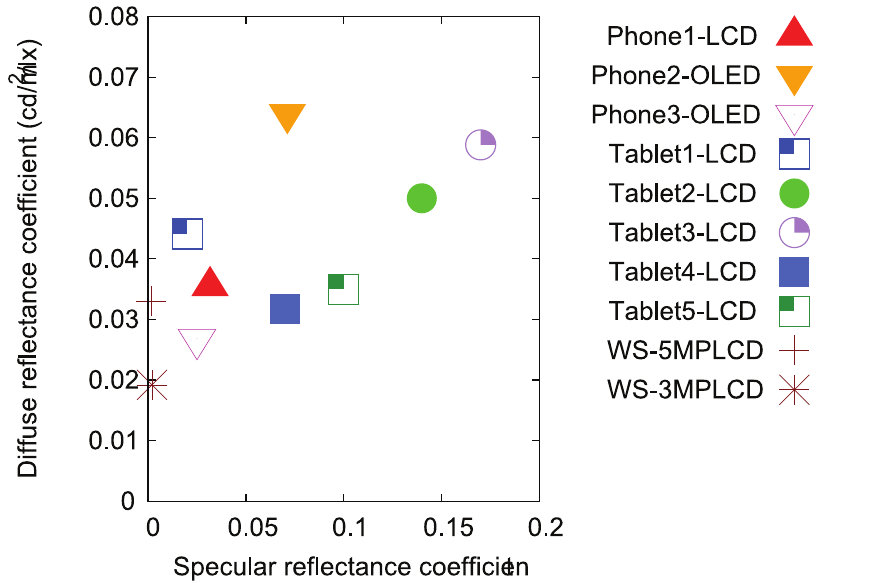
Figure 9. Diffuse reflectance coefficients as a function of specular reflectance coefficients for the devices tested in this study.